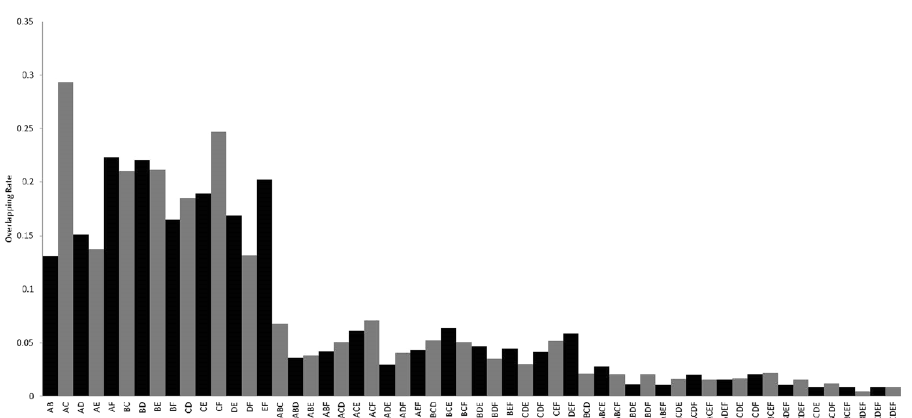
Figure 2. Overlapping rates for different combinations of diagnostic networks. ( A , B , C , D , E and F ) each denotes the diagnostic network GSE70947&PPI, GSE18229&PPI, GSE15852&PPI, GSE20711&PPI, GSE65194&PPI and GSE65212&PPI, respectively, where the network names are defined as the gene expression dataset concatenated with ‘PPI’ (representing BioGRID) by